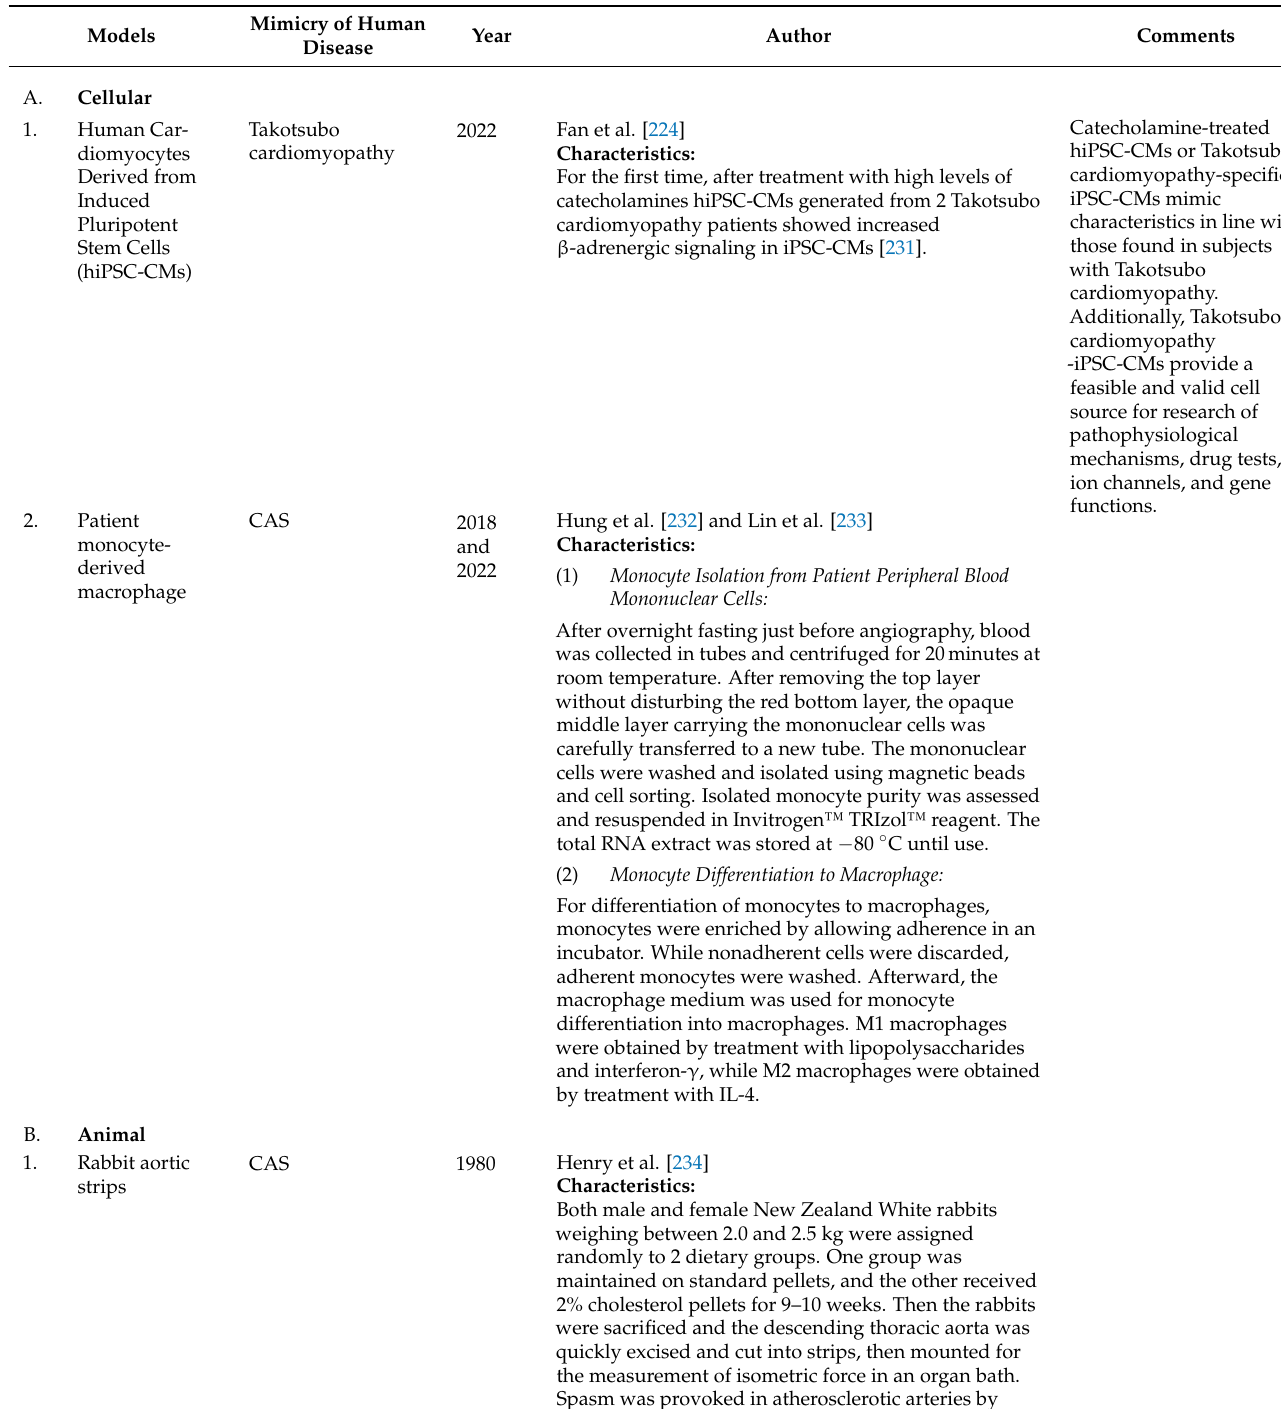
Table 2. Proposed models of takotsubo cardiomyopathy and coronary artery